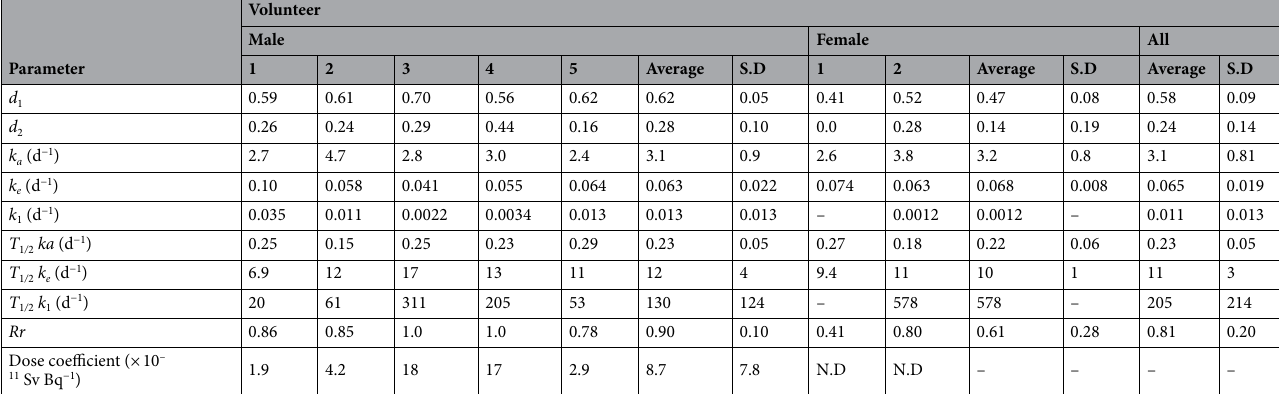
Table 5. Estimated parameters of OBD model for each volunteer administered with D-labelled soybean. S.D., standard deviation.